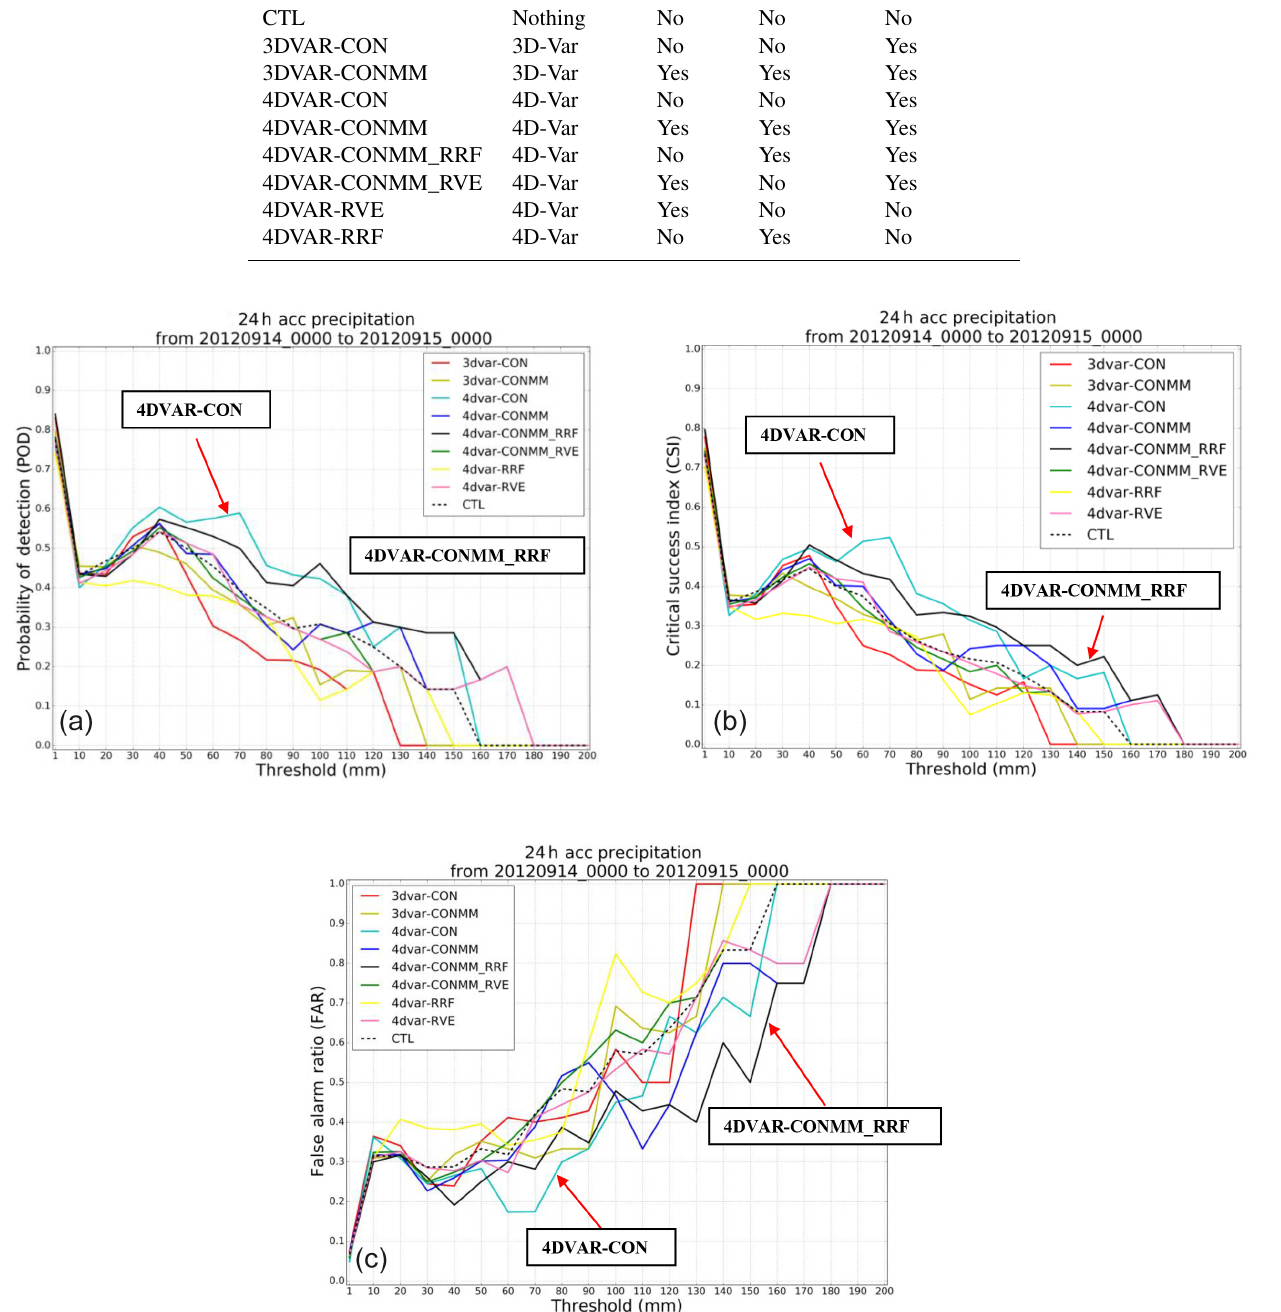
Figure 5. Probability of detection (a) , Critical Success Index (b) and False Alarm Ratio (c) calculated for the nine experiments as a function of thresholds. 4DVAR-CON and 4DVAR_CONMM_RRF simulations (highlighted with a red arrow) show the best values in terms of POD, CSI and FAR for medium thresholds (20–100mm24h − 1 ) and high thresholds (>100mm24h − 1 ),